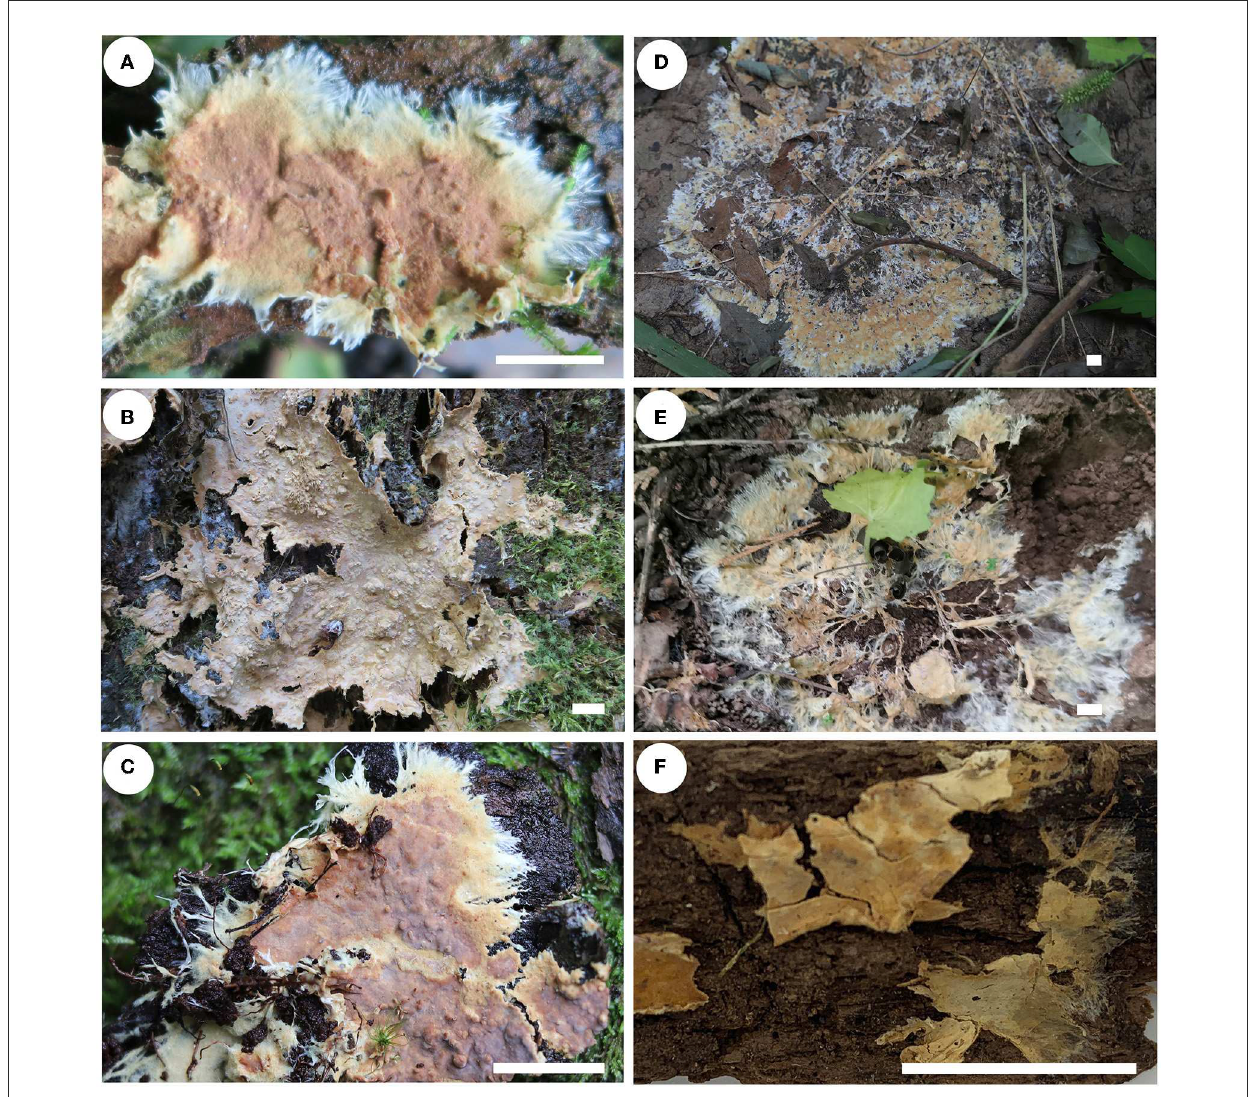
FIGURE8 Basidiomes of Rhizochaete [scale bars: (A–F) = 1 cm]. (A) R. nakasoneae (He 4821, paratype); (B, C) R. subradicata [ (B) He 3213, holotype; (C) He 5561, paratype]; (D, E) R. terrestris [ (D) He 7713, holotype; (E) He 6694, paratype]; (F) R. yunnanensis (He 3302, holotype).